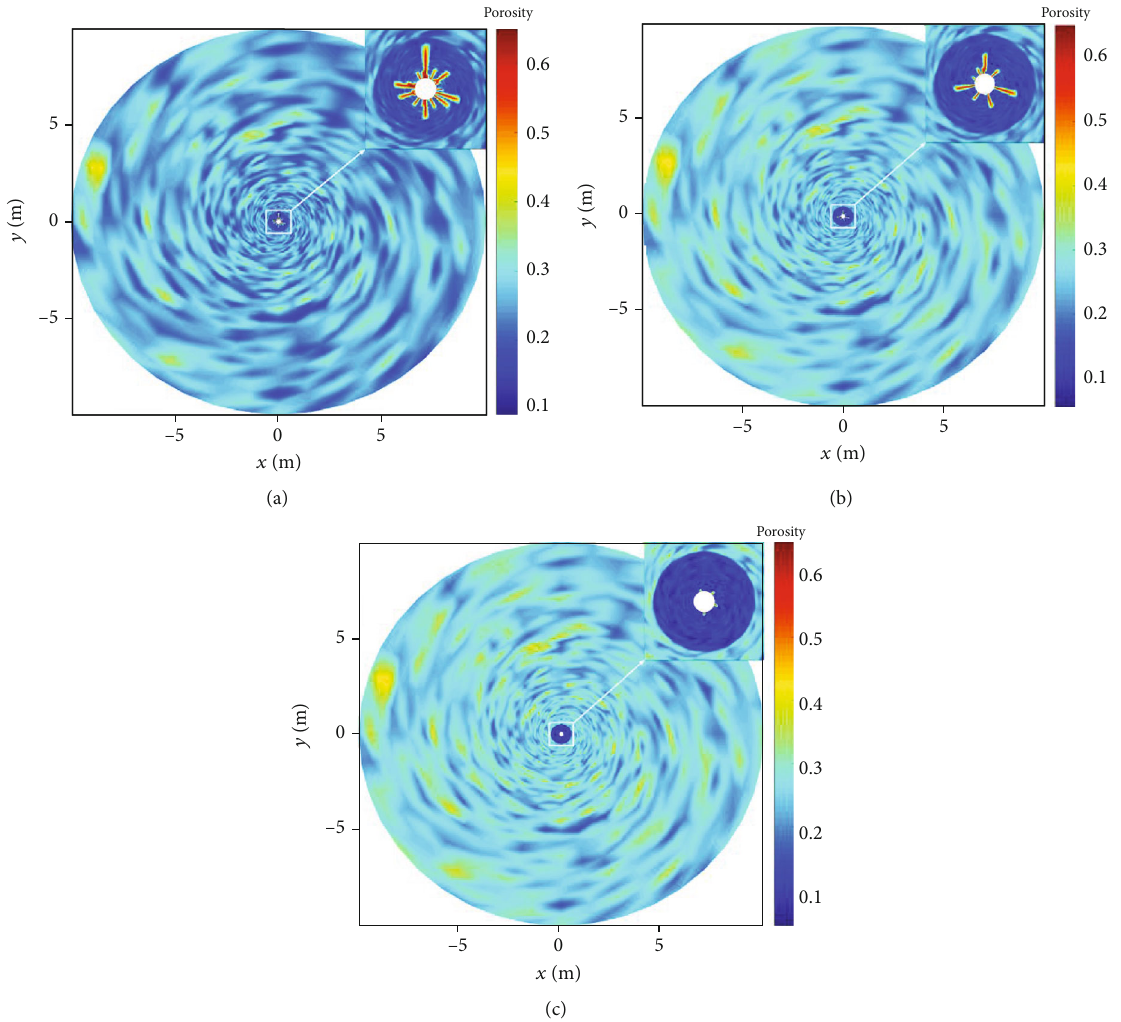
Figure 10: Porosity distribution near the injection well after plugging (injection pressure is 20 MPa). (a) Average porosity in the plugging zone is 0.2. (b) Average porosity in the plugging zone is 0.15. (c) Average porosity in the plugging zone is 0.1.